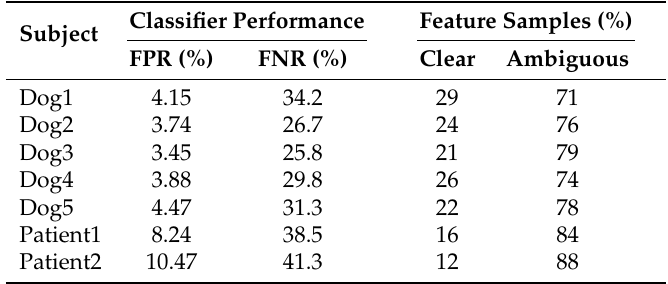
Table 14. Performance of the Support Vector Machine classifier in terms of False Positive Rate (FPR) and False Negative Rate (FNR) for all the subject’s pre-ictal dataset using set t feature set. Classifier performances of only the best iterations are shown.